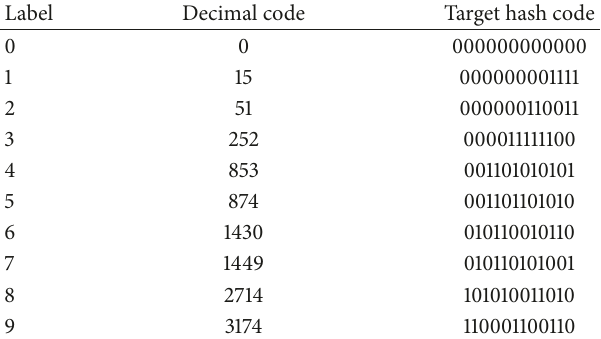
Table 2: Semantically uneven target 12-bit hash code set for a 10- category dataset: Hamming distances between codes 0, 1, and 2 are small and those between codes 7, 8, and 9 are